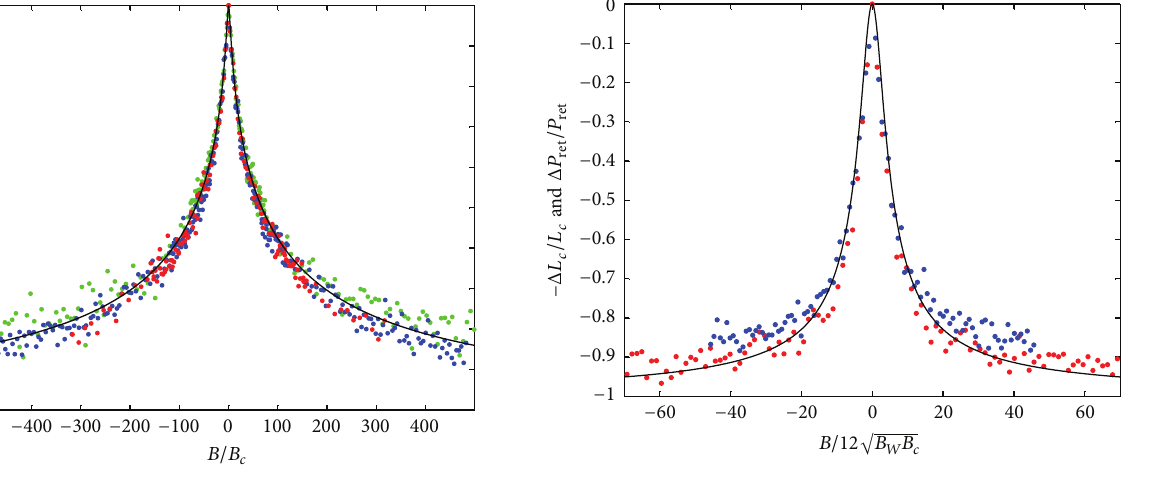
Figure 2: We compare the analytical expression (solid line) for /𝑃 Δ𝑃 from (13) with the numerically obtained relative change in ret ret thelocalizationlengthusingtheparameter 𝐵 𝑒 = 100𝐵 𝑐 .Thedifferent dot colors (green, blue, and red) represent different widths (40 ×𝑎 , 80 ×𝑎 , 120 ×𝑎 ) of the simulated graphene device, where 𝑎 is the lattice constant.